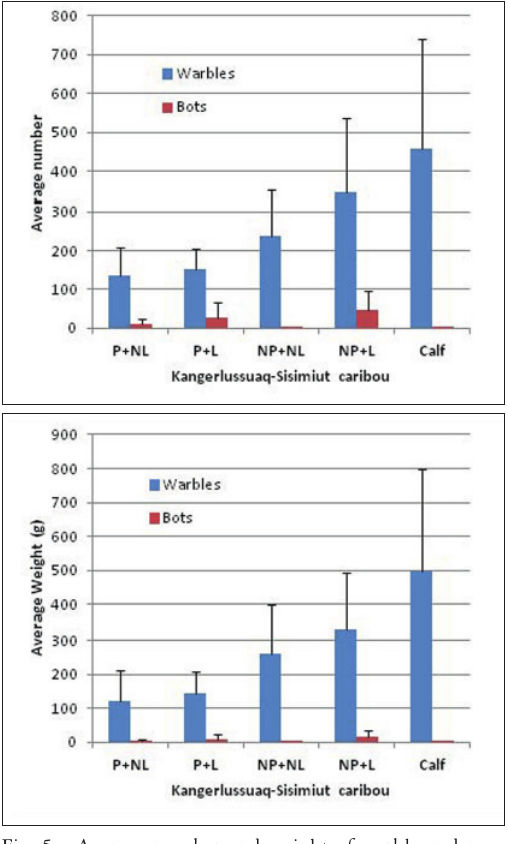
Fig. 4. Average number and weight of warble and nose bot larvae in Akia-Maniitsoq caribou collected in March/April 2008 in West Greenland: preg- nant & not-lactating (P+NL) n = 23; pregnant & lactating (P+L) n = 4; not-pregnant & not-lac- tating (NP+NL) n = 9; not-pregnant & lactating (NP+L) n = 4; calf n = 6.